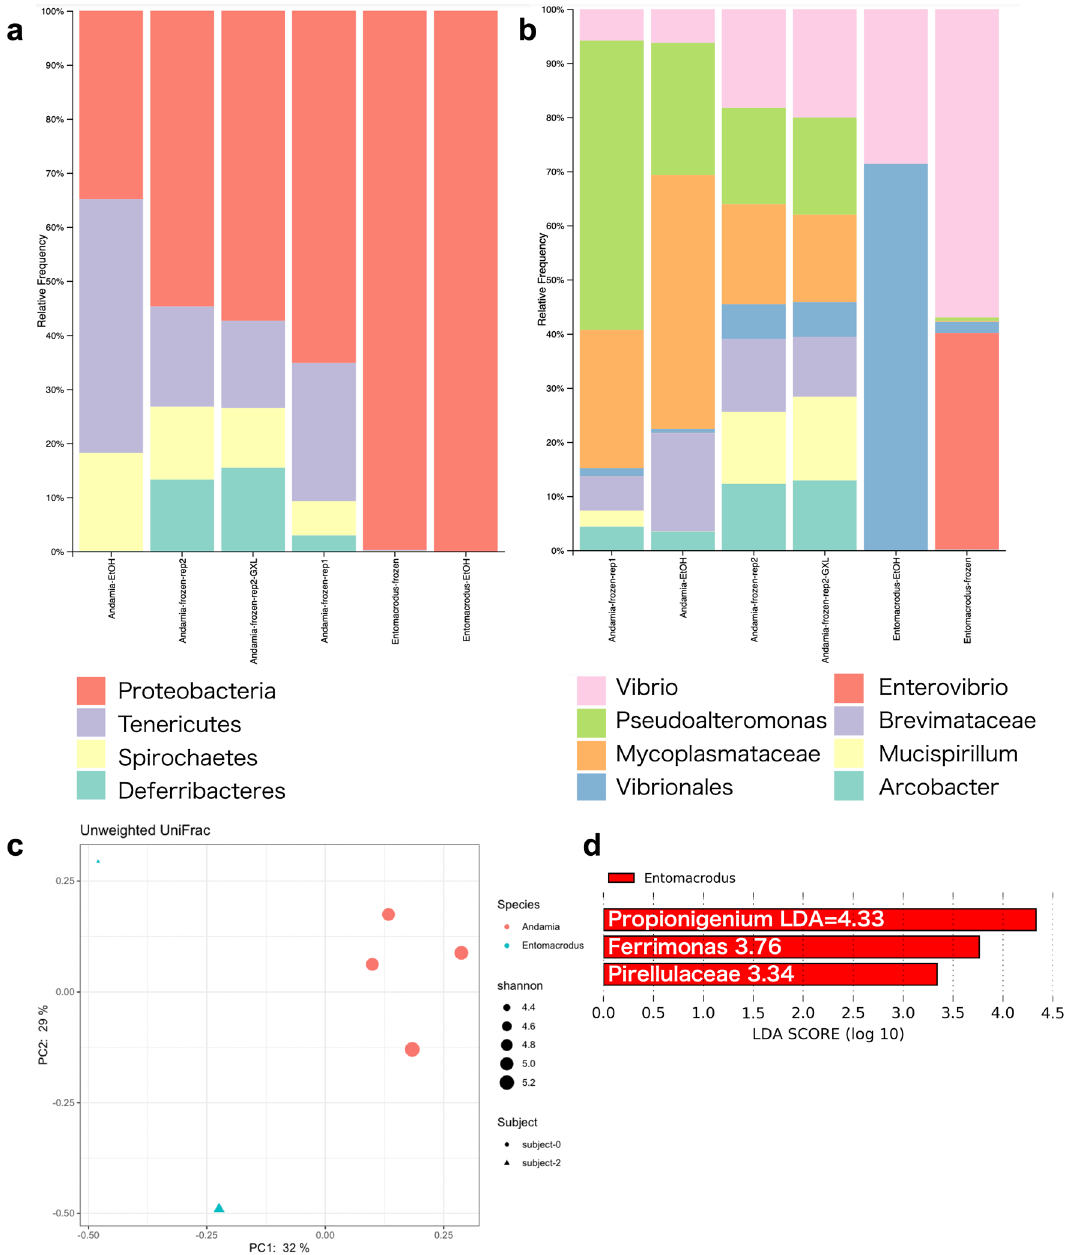
Figure 3. Major groups of bacteria detected by 16S rDNA amplification from Andamia tetradactylus and Entomacrodus stellifer . (a) Relative abundance of phylum (class 2) category was shown in individual gut microbiome samples. Categories with less than 10,000 reads are not shown to represent a major proportion of the bacterial population. (b) Relative abundance of genus (class 6) category was shown in individual gut microbiome samples. For the three groups, Mycoplasmataceae, Vibrionales, and Brevimataceae, their family or order names are given since they have not yet been identified as genera. (c) Principal Coordinate Analysis (PCoA) plots using distance matrices for beta-diversity (unweighted UniFrac distance). (d) A forest plot showing differentially abundant bacterial taxa that were significantly different between species groups as determined using the Kruskal–Wallis test. LDA score (effect size) indicating significant differences in bacterial taxa (LDA score > 3.0; alpha value p <